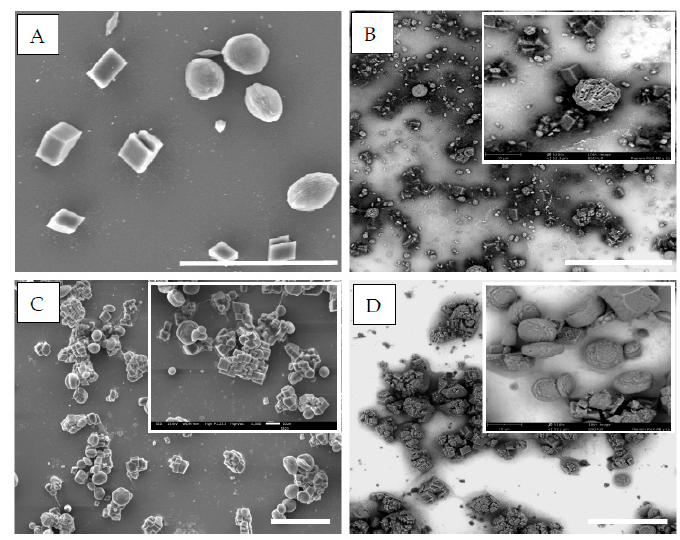
Figure 3. SEM images of CaCO 3 crystals obtained through EC on modified ITO electrodes: control (bare ITO) ( A ), ALG Les modified ITO ( B ), ALG Les /MWCNT modified ITO ( C ), ALG Les /MWCNT-OX modified ITO ( D ). Scale bar = 50 μ m. Inset scale bar = 10 μ m.